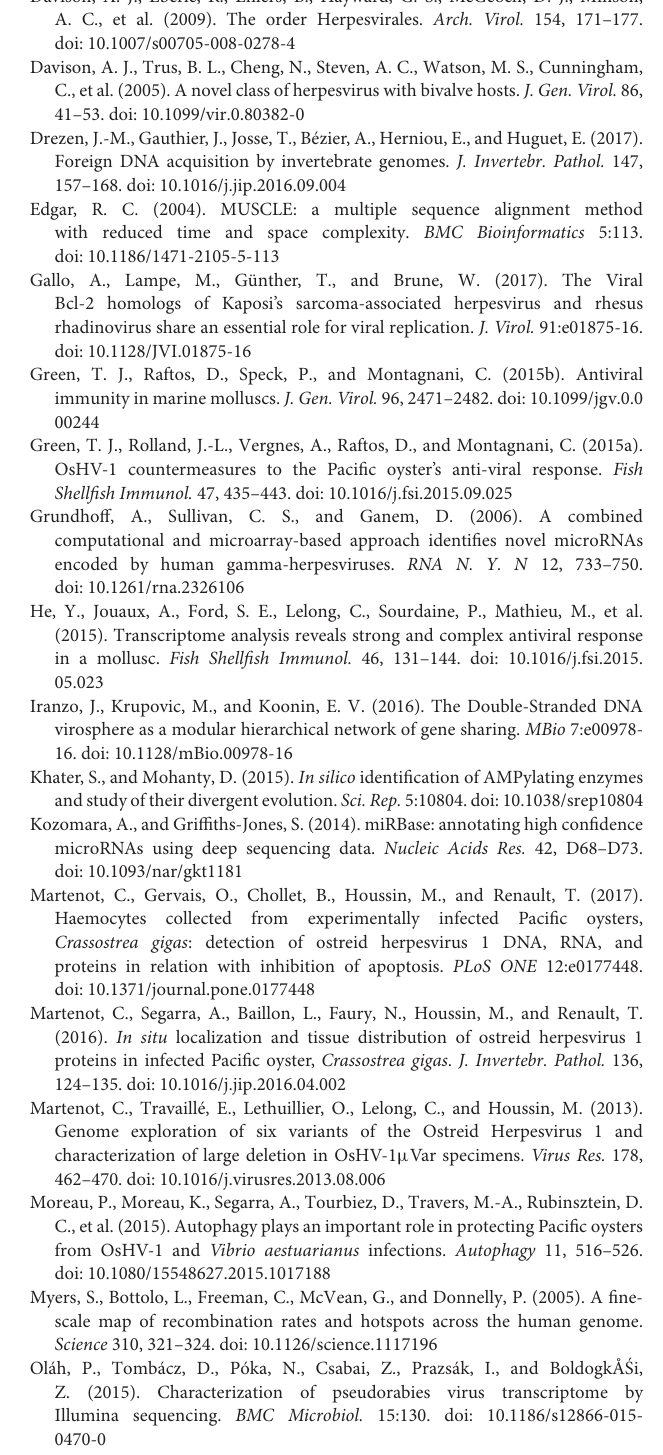
viral ORFs. ORFs are clustered based on their TPM values using an Euclidean distance algorithm. “High” samples are framed in black. See the color legend at the bottom of the